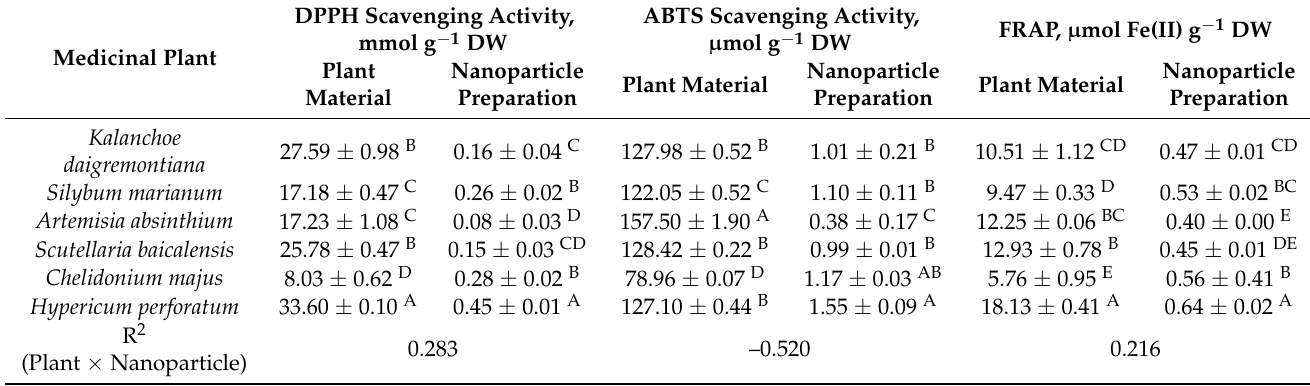
Table 2. Antioxidant properties of plant material and plant-derived nanoparticle preparations ( x ± SD , n = 3 ) . Different letters within the column indicate statistically significant differences between means, according to Tukey’s test, at the confidence level p ≤ 0.05. Determination coef- ficient represents the corelation between measured antioxidant parameters in plant extract and nanoparticle